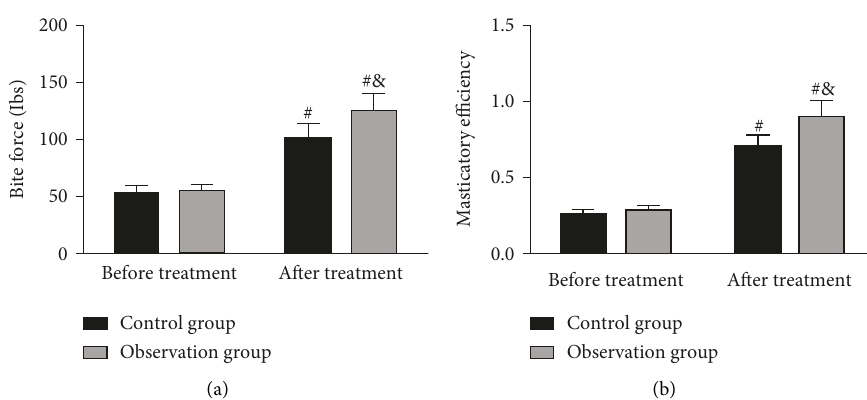
Figure 4: Comparison of masticatory ability. (a) Comparison of bite force between the research group and control group. (b) Comparison of masticatory efficiency between the research group and control group. Note. # indicates that the difference is statistically significant compared with that before treatment ( P < 0 . 05), and & indicates that the difference is statistically significant compared with the control group ( P < 0 .